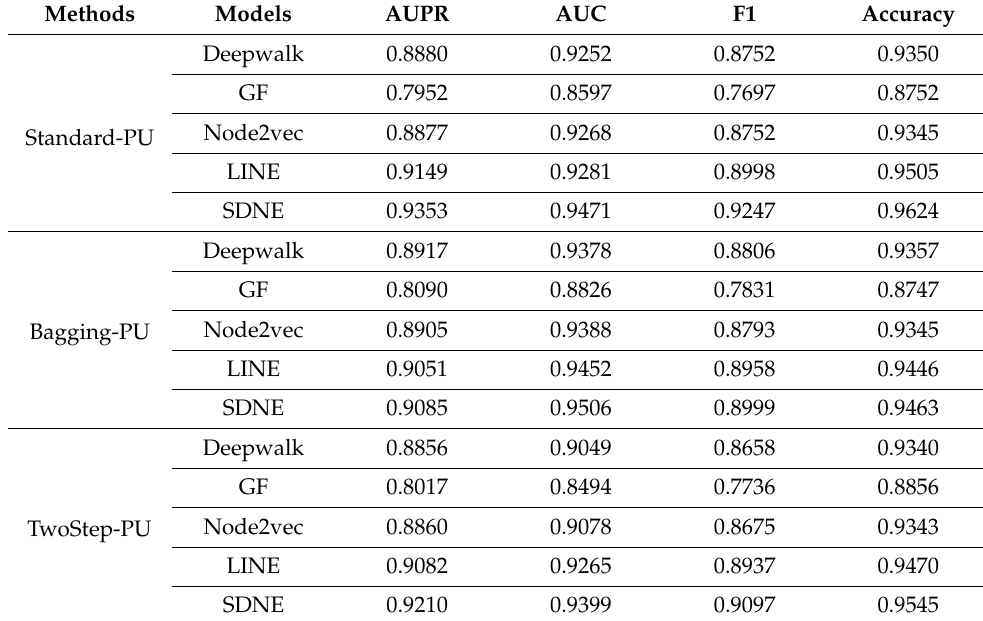
Table 3. The performance of several network representation learning models using different positive- unlabeled learning strategies on the DrugBank